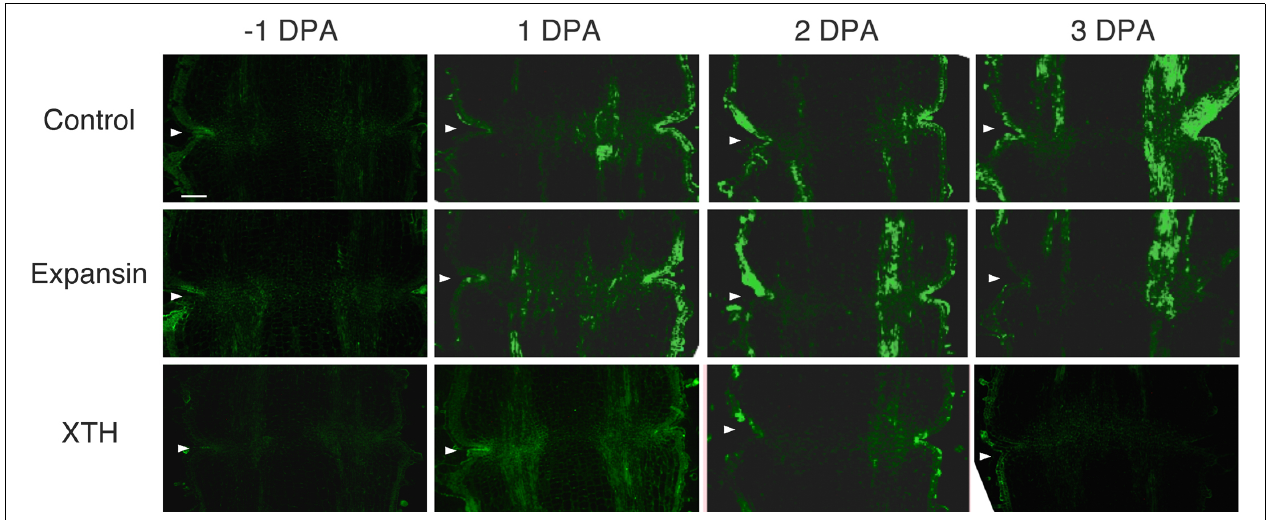
(cid:0) 1 DPA flower pedicels, including the AZ, were stained with the anti-expansin and anti-xyloglucan antibodies. Micrographs show the negative control without the first antibody step. Arrowheads indicate the AZs. Bar = 0.2 mm.